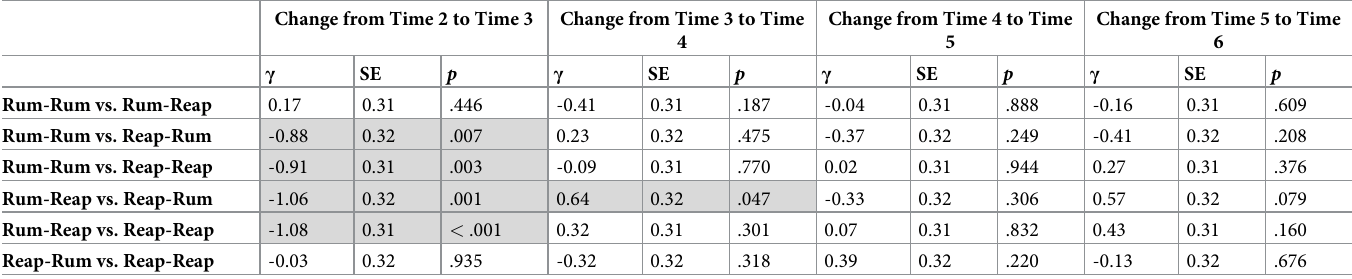
Table 4. Tests of differences between conditions in the size of the change in anger ratings across time-points. Change from Time 2 to Time 3 Change from Time 3 to Time